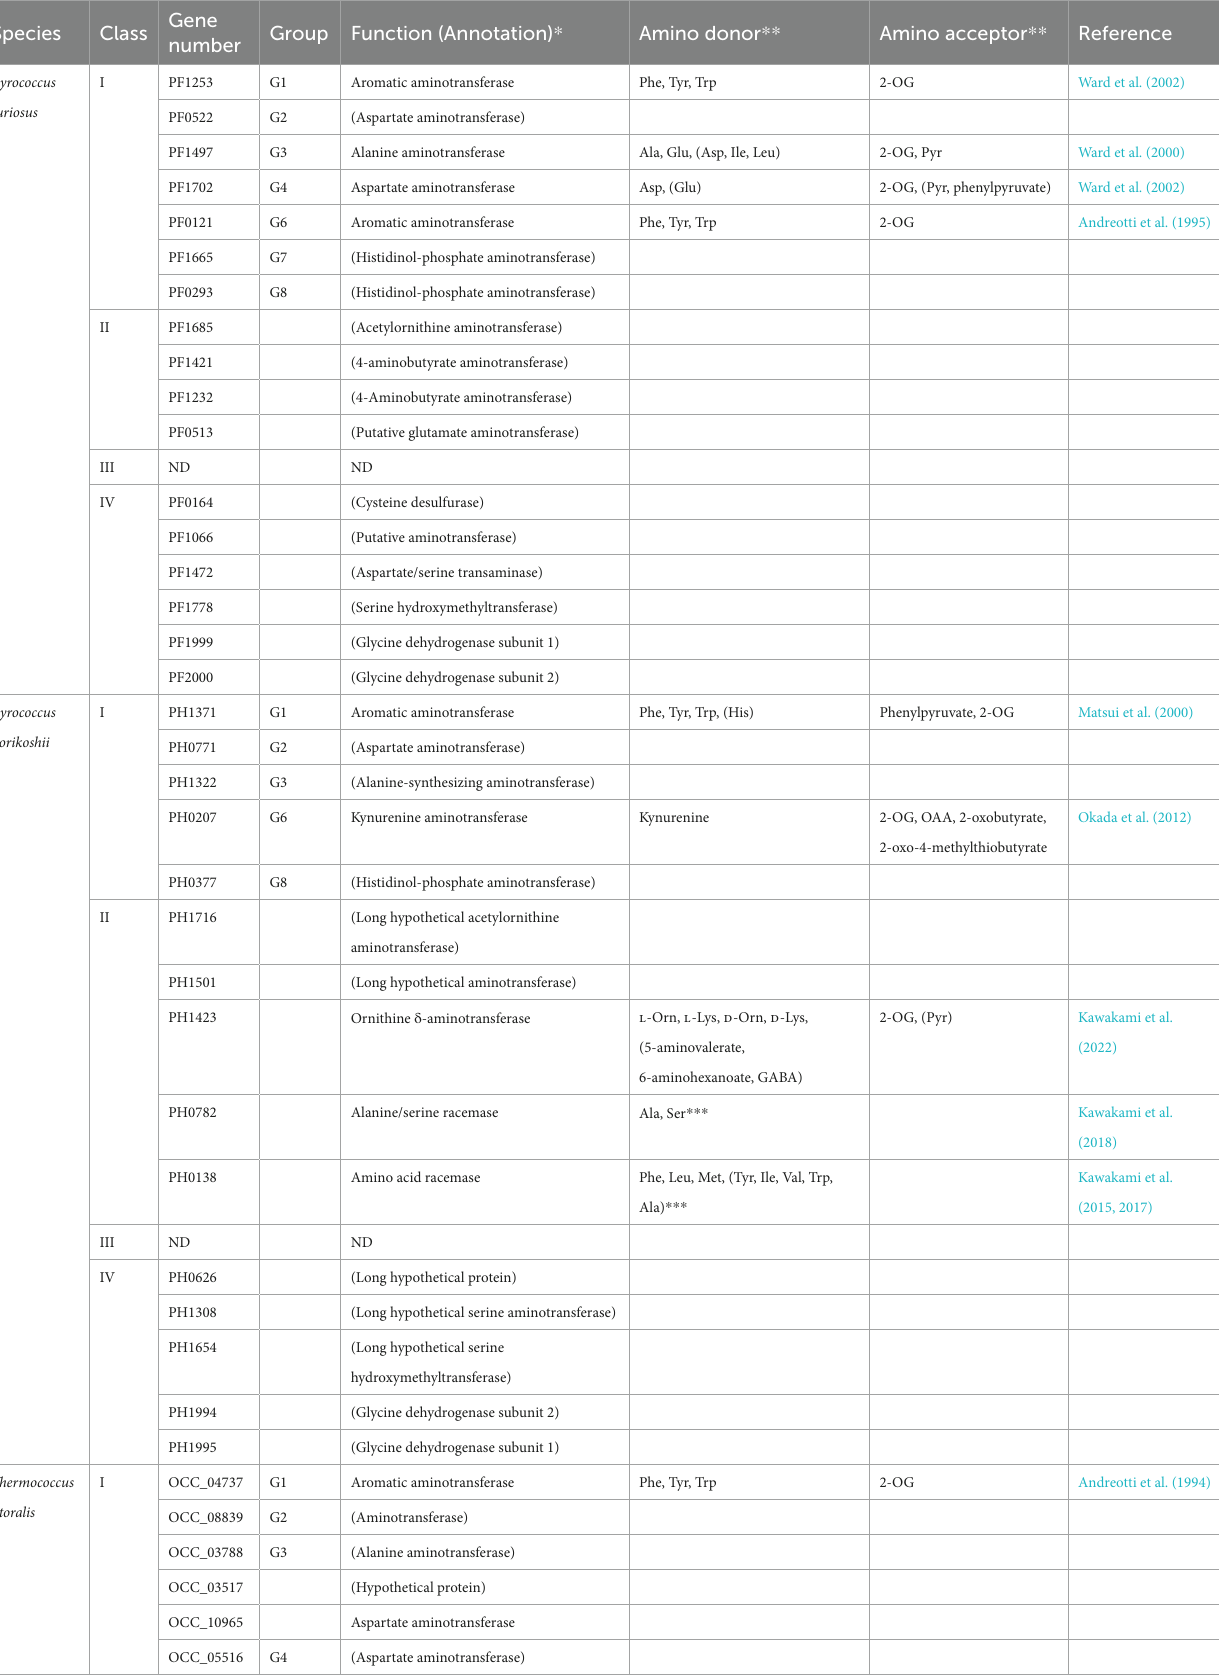
TABLE 3 An overview of aminotransferase homologs in